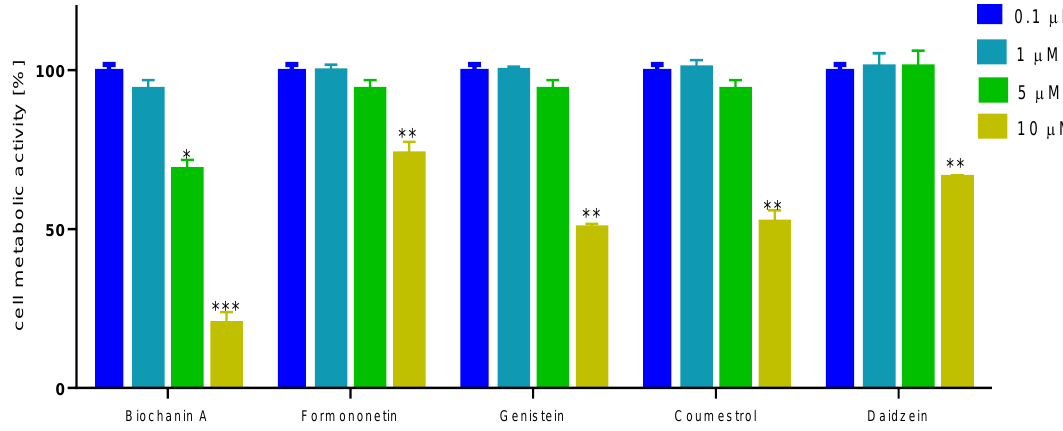
Figure 5. The influence of isoflavones on Saos-2 cells metabolic activity determined by PrestoBlue assay after 14 days exposure. Control cells were not exposed to any compound but the vehicle; values are means ± standard deviations from at least three independent experiments ( n ≥ 16); statistical significance was calculated versus control cells (untreated); * p ≥ 0.05, ** p ≥ 0.01, *** p ≥ 0.001.